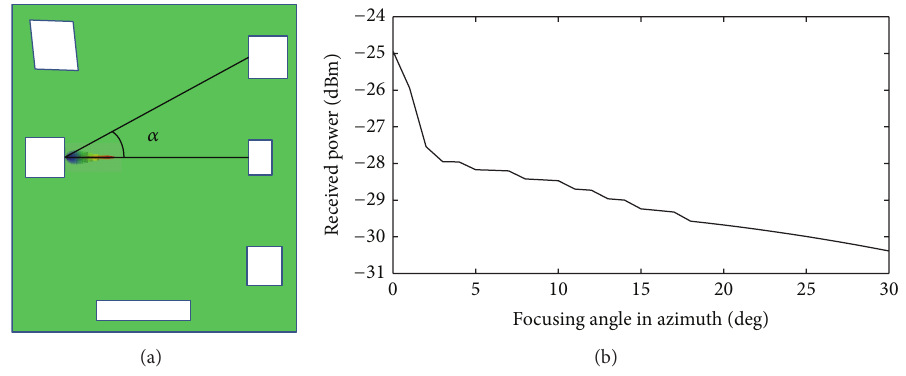
Figure 8: (a) 2D scenario and (b) received power for different focusing angles (broadside R = 200 m).